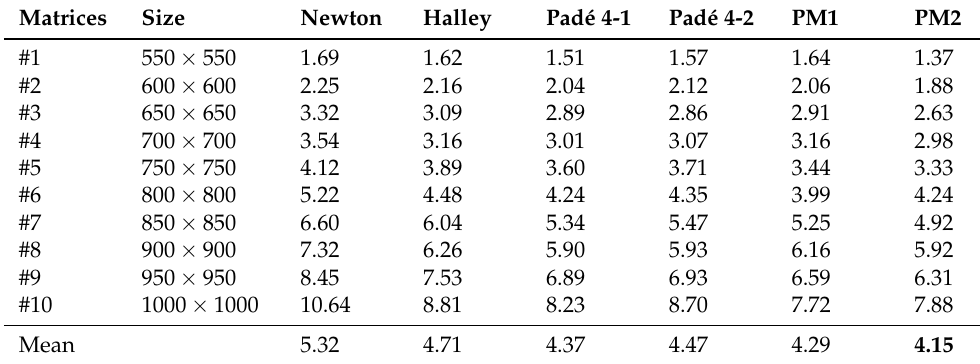
Table 2. Results of comparisons based on CPU time (seconds) for Experiment